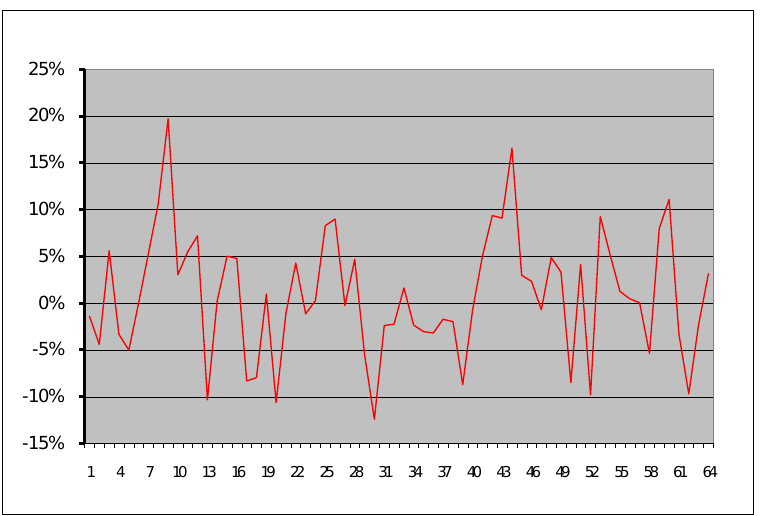
Figure 6. Plot of the differences in percentage of coverage between the template images and the computed